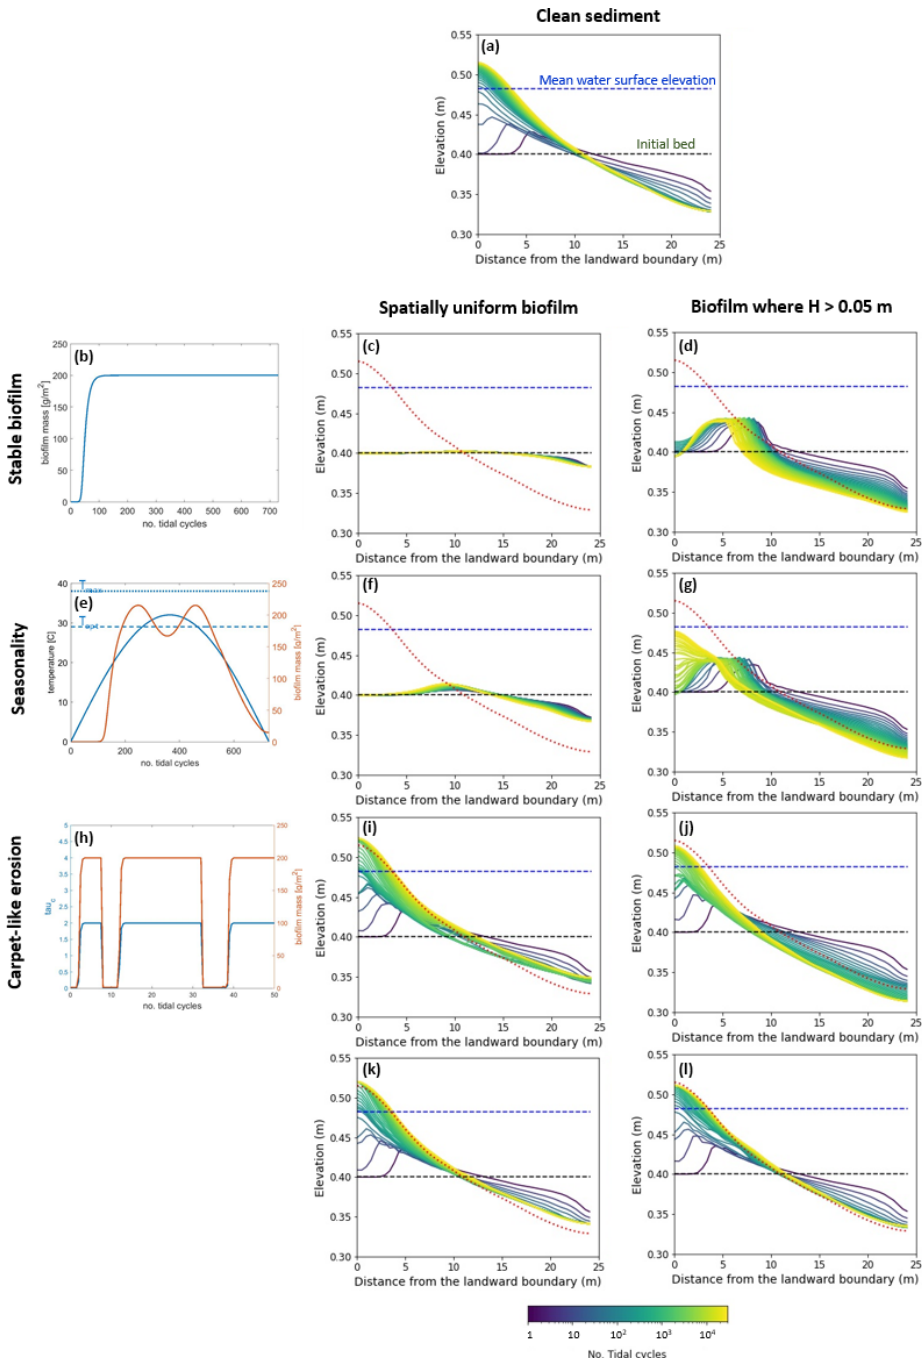
Figure 5. Bed evolution after 30000 tidal cycles under different biofilm conditions. Panel (a) shows the bed evolution in the reference case with clean sediment. The panels in the left column represent the time evolution of biofilm during the simulation, showing stable biofilm (b) and the effect of seasonality (e) and carpet-like erosion (h) . The rows represent, respectively, the bed evolution under these biofilm conditions. The panels in the central column show the bed evolution profile in the case of biofilm being uniformly distributed spatially. The panels in the right column show the bed evolution profile in the case of biofilm being developed only in locations where the water depth is smaller than 0.05m. The bed profiles are compared with the final bed elevation of clean sediment at equilibrium (dashed red lines). The dashed blue and green lines represent the initial water surface elevation and the initial bed profile,